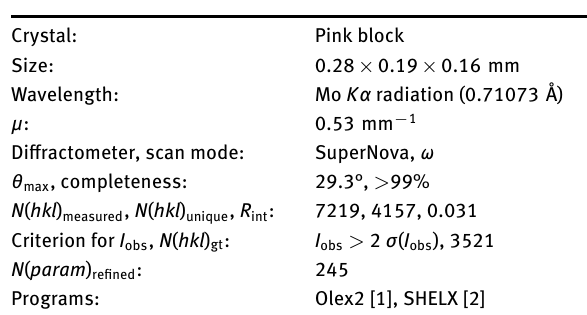
Table 1: Data collection and handling.